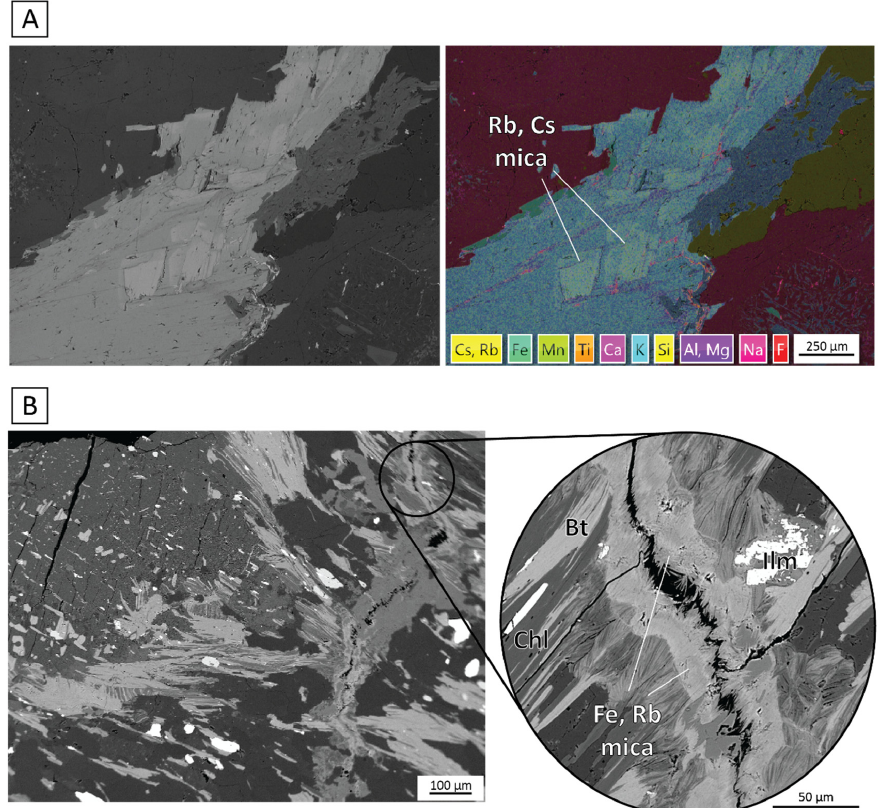
Figure 10. Example of BSE images and EDS map of halo micas showing enrichment in the elements discussed. ( A ) Micas in granitic wall rock enriched in Rb, Cs and probably Li (ACL 13-05). ( B ) Micas enriched in Fe, Rb (and probably Li), tentatively classified as siderophyllite, in fractures in the hanging wall mica schist approximately 3 m from the top of a spodumene pegmatite intersection (ACL